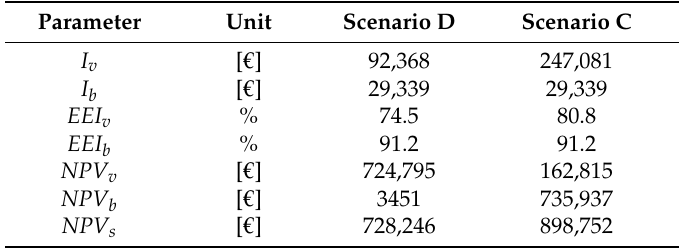
Table 1. Main results of the numerical